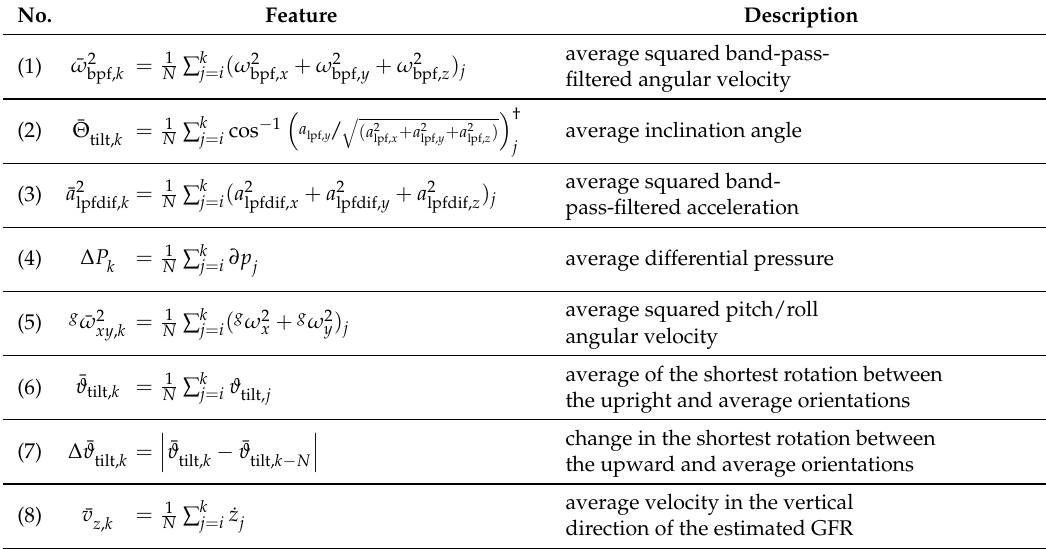
Table 2. Features extracted from the accelerometer, gyroscope, and barometric altimeter.